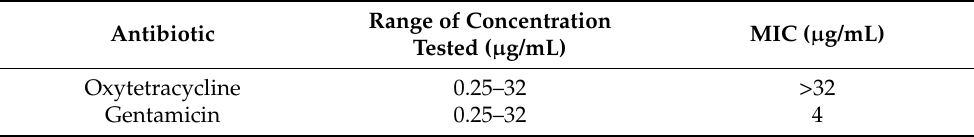
Table 1. Minimal inhibitory concentration (MIC) of oxytetracycline and gentamicin.